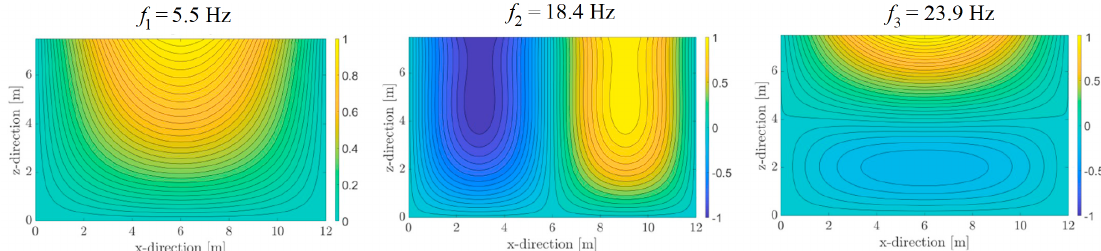
Figure 2. Example: First three modal shapes and frequencies of fictitious, three–sided simply supported model for a coastal sluice gate, adapted from Tieleman et al. [1], with permission from Elsevier, 2020. Width * height * thickness = 12 × 7.5 × 0.243 m. E = 200 × 10 9 kg/m 3 and ν = 0.3. Modal periods include the effects of fluid–structure